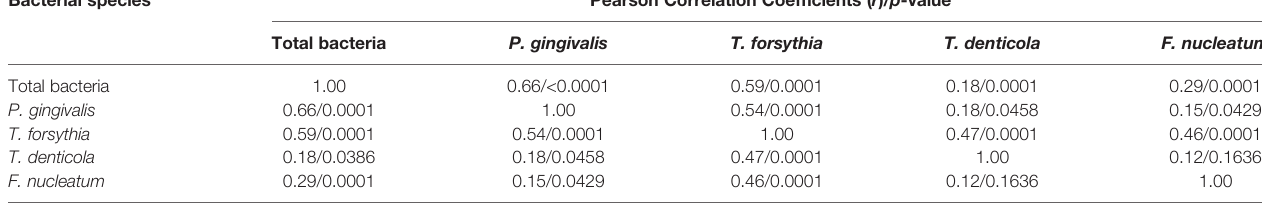
TABLE 7 | Correlation between levels of bacterial species. Bacterial species